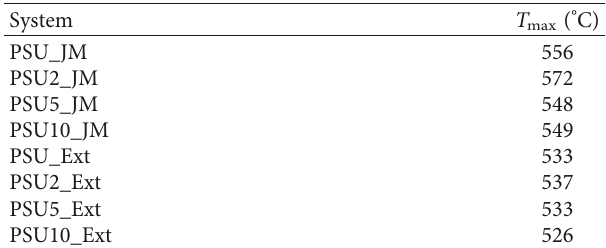
Figure 3: (a) TGA weight losses versus temperature for PSU_JM and PSU_Ext. (b) Initial decomposition temperature ( T content (wt.%). Table 1: Temperature at the maximum degradation rate ( T PSU_JM and PSU_Ext as measured at the minimum of the cor- responding